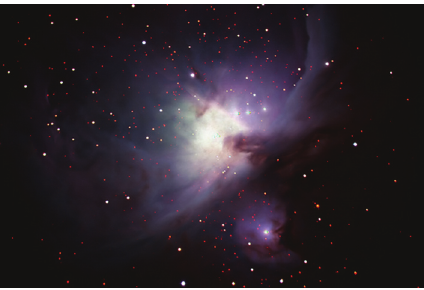
Figure 9: IC 434 and M42 images obtained by using the T35